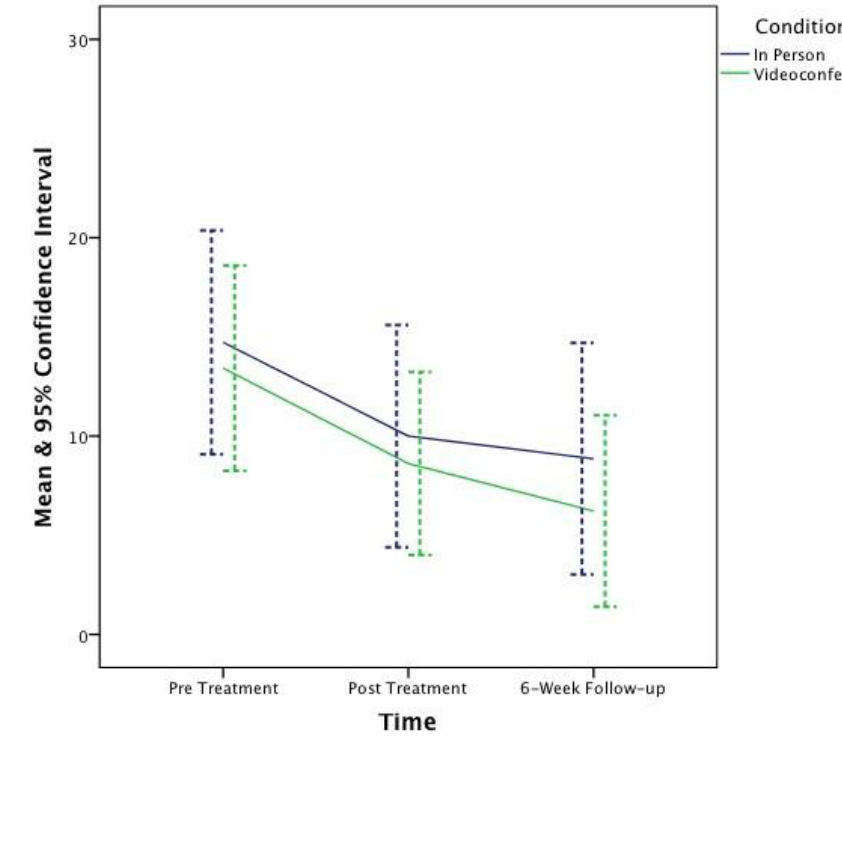
Figure 3. The change in symptoms of anxiety across time and